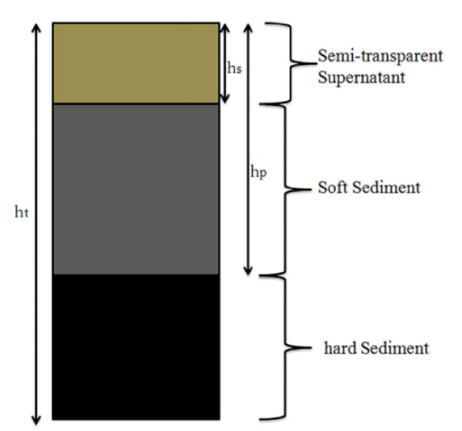
Figure 1. The schematic diagram of the coal water slurry in the measuring cylinder.